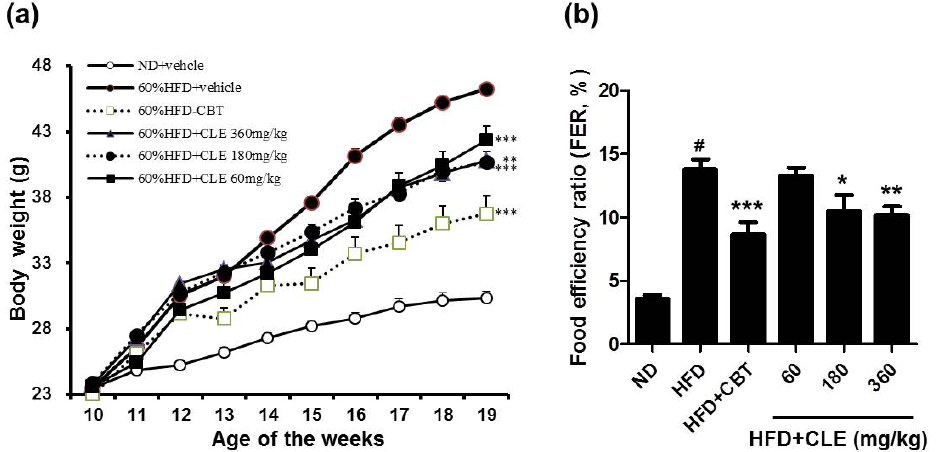
Figure 1. Effect of Codonopsis lanceolata extract (CLE) on body weight and food efficiency ratio (FER) in high fat diet (HFD)-fed mice. ( a ) Effect of CLE on body weight gain in HFD-fed mice. ( b ) Effect of CLE on FER in HFD-fed mice. Food efficiency ratio (FER) = increased body weight (g)/food intake (g). Values are the mean ± SEM ( n = 10), # p < 0.05 vs. ND-fed mice, * p < 0.05, ** p < 0.01, *** p < 0.001 vs. HFD-fed mice. ND: normal chow diet, HFD: 60% high fat diet + vehicle, HFD + CBT: 60% high fat diet + reductil (CBT, 2 mg/kg), HFD + CLE: 60% high fat diet + CLE (60, 180 and 360 mg/kg, respectively).